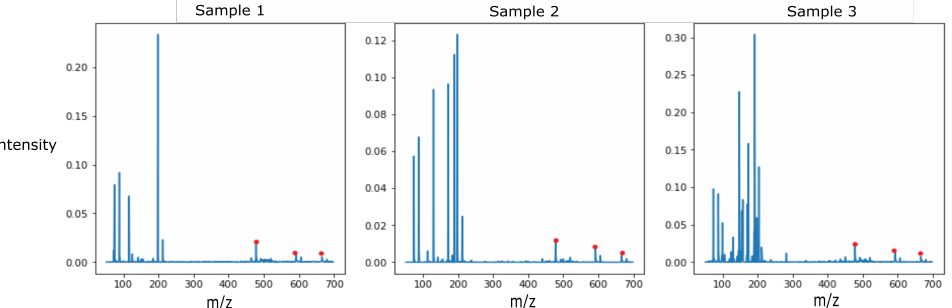
Figure 4. Detected VOCs at m/z 478.3883, m/z 592.2332, and m/z 666.2437 for all 3 samples of Proteus mirabilis